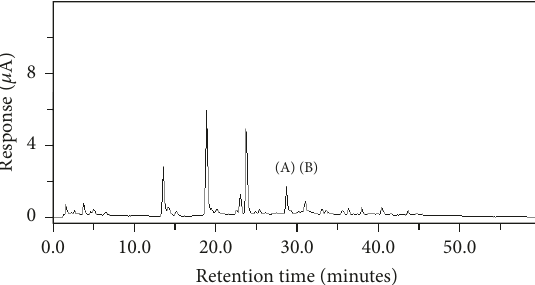
Figure 2: HPLC chromatograms of the extract prepared from the mixed green coffee sample. The mixture of seven green coffee samples (1 Nature Made Inc., 2 BioRise Nutrition, 3 GMX Naturals, 4 Natrogix, 5 Pro Nutrient Labs, 6 The Health Life, and 7 Wellsome Nutrition) was extracted with 70% MeOH (50mL). The extract was analyzed using the HPLC method as described in Materials and Methods, and the peaks of javamide-II (A) and javamide-I (B) were detected using an electrochemical detector and confirmed by NMR spectroscopic